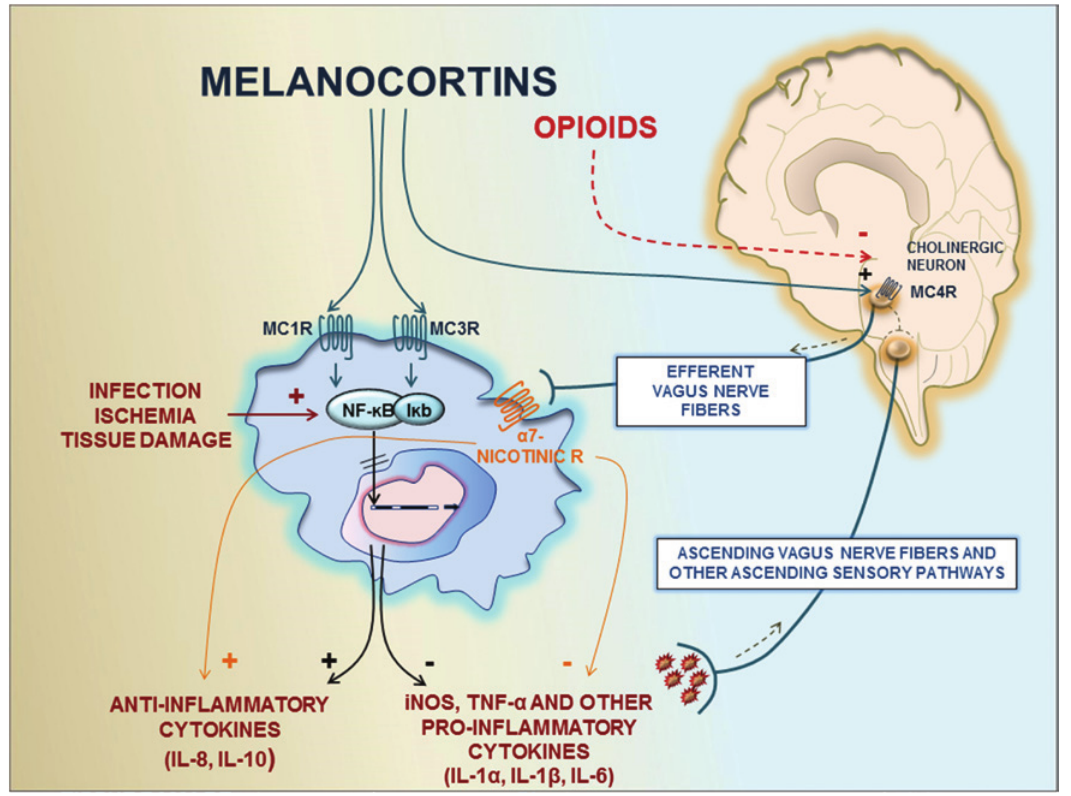
Figure 2: Mechanisms of the anti-inflammatory effect of elanocortins. The non-adrenal-mediated antiinflammatory effect of pharmacological doses of melanocortins involves (i) the activation of MCRs (predominantly MC1R and MC3R) on immunocytes, with consequent inhibition of the translocation of the ubiquitary early transcription factor NF-kB into the nucleus and of the ensuing, NF- κ B-dictated, overproduction of several factors of the inflammatory response; and (ii) the triggering of the ‘inflammatory reflex’ or ‘brain cholinergic antiinflammatory pathway’, which through the activation of α 7-nicotinic receptors on immunocytes inhibits the overproduction and release of inflammatory cytokines while stimulating the production and release of antiinflammatory cytokines. (Opioid peptides, massively released during shock, on the contrary inhibit the ‘inflammatory